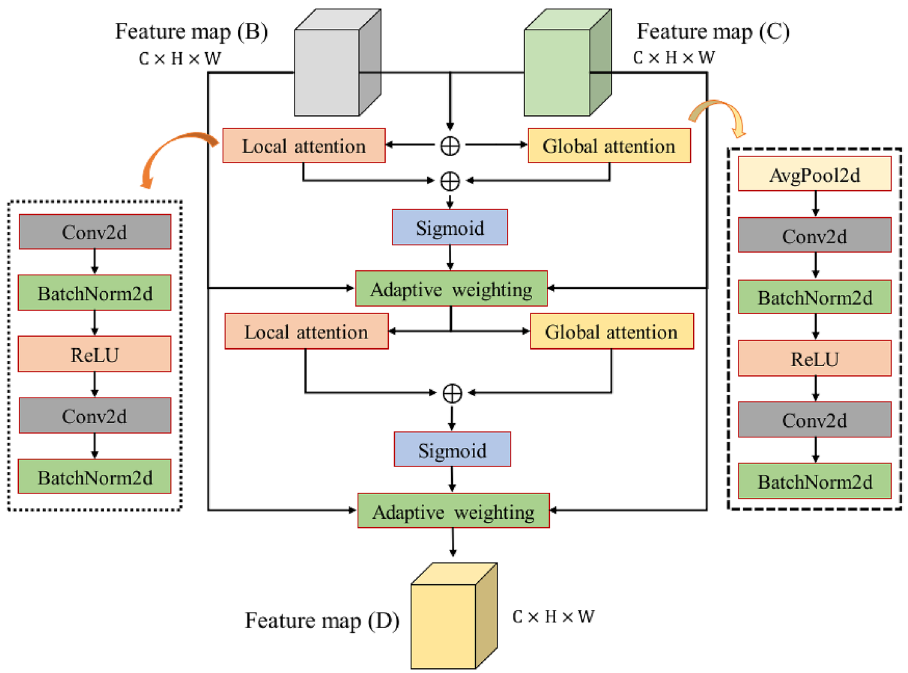
Figure 4. Asymmetric adaptive iterative attention feature fusion module. The input feature maps are B and C, and the output feature map is D